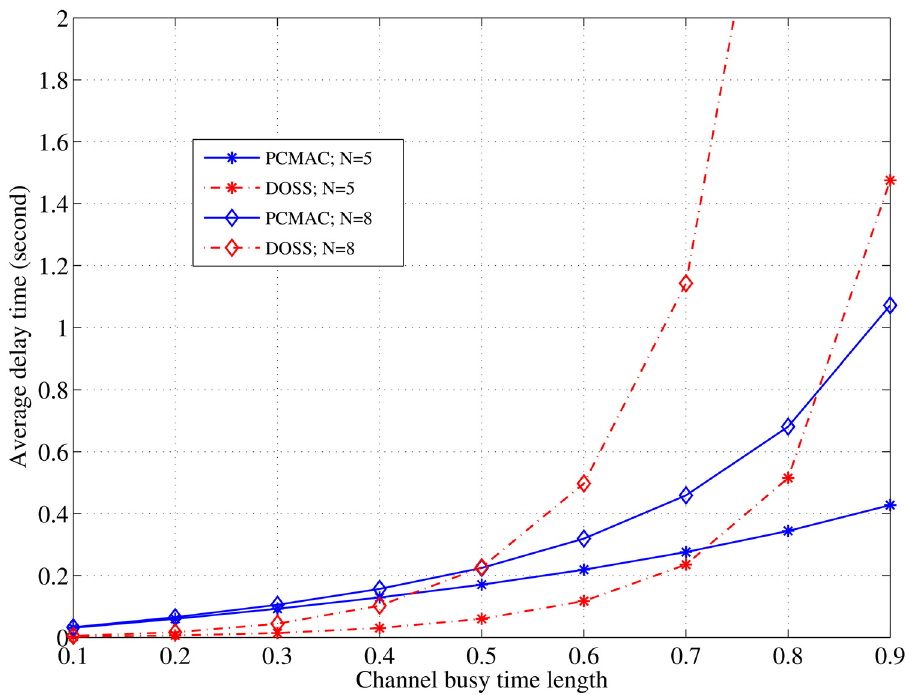
Fig 7. Average delay comparison between PCMAC and DOSS MAC protocols; C = 5; λ LQ = λ HQ = 2 [pkt/s]; L = 3kb.